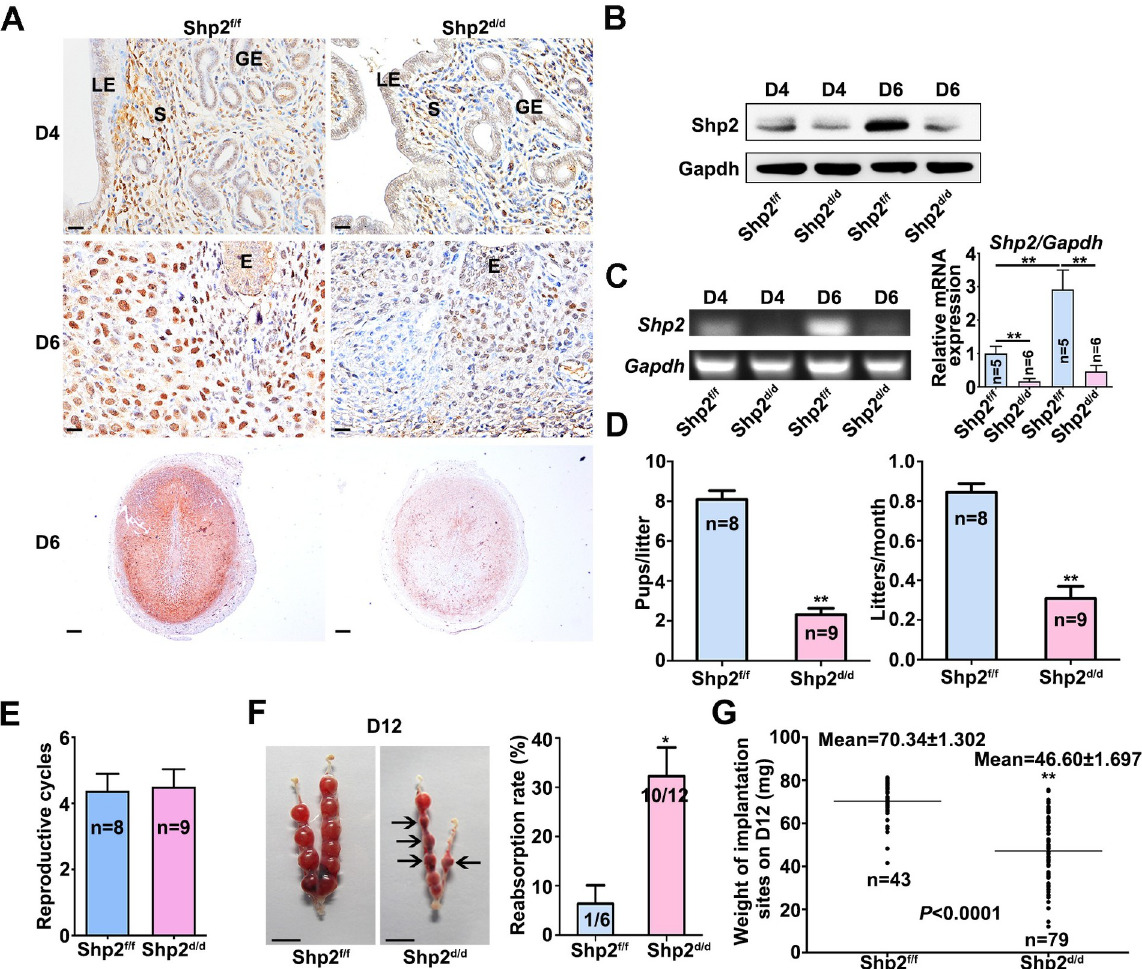
Fig 1. Deletion of Shp2 from the uterine mesenchyme results in female subfertility. (A-B) Shp2 protein levels were detected by immunohistochemistry ( A ) and western blot ( B ) in Shp2 f/f (n = 6) and Shp2 d/d (n = 7) D4 and D6 uteri. Gapdh served as the loading control. Brown color indicates positive staining. Tissues were counterstained with hematoxylin. Scale bars for the top 4 images in panel A, 20 μ m; Scale bars for the bottom two images in panel A, 200 μ m. LE, luminal epithelium. GE, glandular epithelium. S, stroma. DZ, decidual zone. E, embryo. (C) Detection of Shp2 mRNA in Shp2 f/f (n = 6) and Shp2 d/d (n = 7) D4 and D6 uteri by reverse transcription PCR. Quantitative analysis of Shp2 mRNA expression as showed in the right. (D) The fecundity of Shp2 f/f (n = 8) and Shp2-deficient female mice (n = 9) was evaluated by analyzing their litter sizes and numbers of litters per month. The number within the bar indicates the number of mice examined. (E) Reproductive cycles between Shp2 f/f (n = 8) and Shp2 d/d (n = 9) female mice during 6-month breeding experiment. (F) Representative photographs of uteri and the reabsorption rates of embryos of Shp2 f/f (n = 6) and Shp2 d/d mice (n = 12) on D12. The arrows indicate degenerating and reabsorbing embryos. Scale bars, 1000 μ m. The numbers within the bars indicate the number of mice with reabsorption sites per the total number of mice examined. (G) Implantation site weight of embryos of Shp2 f/f (n = 6) and Shp2 d/d mice (n = 12) on D12. The data are presented as mean ± SD from at least 6 mice in each group or three independent experiments. Statistical difference is indicated: � P < 0.05; �� P < 0.01; ��� P < 0.001.